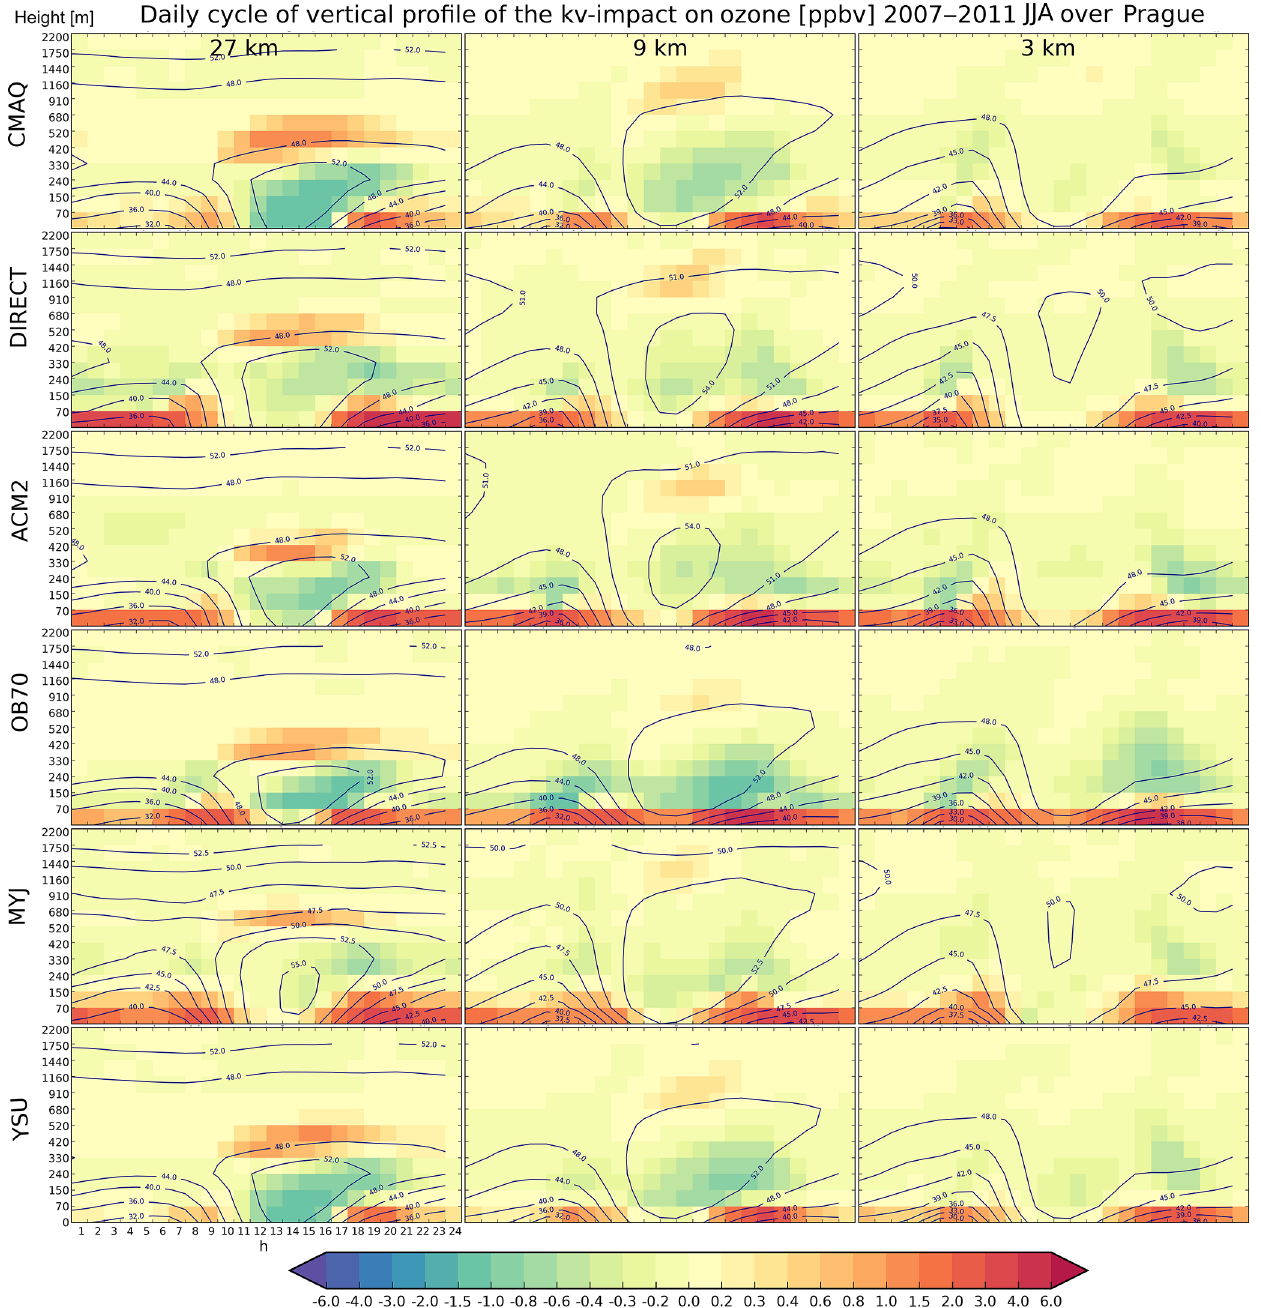
Figure 21. The impact of the urbanization-induced K v enhancement (i.e., increase of vertical eddy diffusivity) on the diurnal cycle of the O 3 profile over Prague for JJA. Columns represent the three resolutions (27, 9 and 3km, from left to right). Rows correspond to individual K v methods. Colors indicate the difference; contours stand for the absolute concentrations (from the total-impact). Units are in